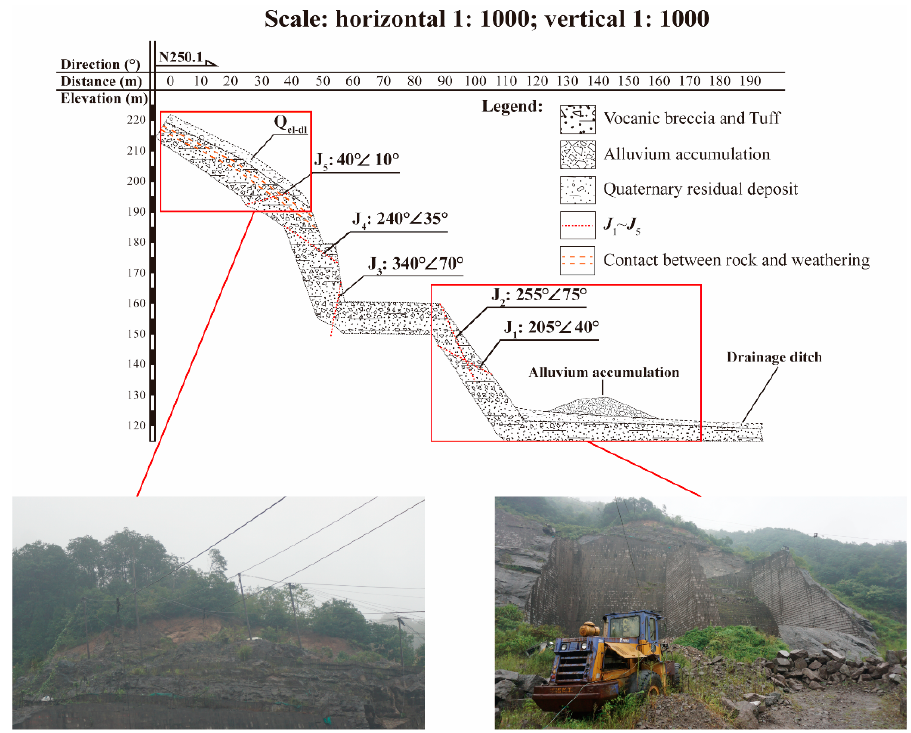
Figure 4. Cross-sectional view and the front view s of the Jidong town quarry slope.